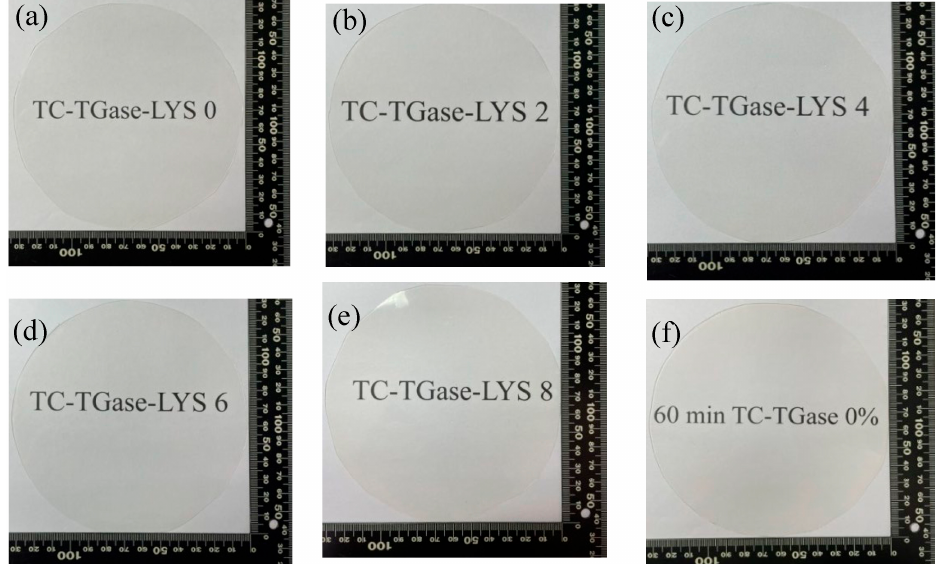
Figure 1. Photographs of transglutaminase (TGase) cross-linked tilapia collagen (TC) fi lms incorporated with lysozyme (LYS). ( a ) TC-TGase-LYS-0, ( b ) TC-TGase-LYS-2, ( c ) TC-TGase-LYS-4, ( d ) TC-TGase-LYS-6, ( e ) TC-TGase-LYS-8 and ( f ) control fi lm. Table 1. Color a tt ributes and opacity of transglutaminase (TGase) cross-linked tilapia collagen (TC) fi lms incorporated with lysozyme (LYS).